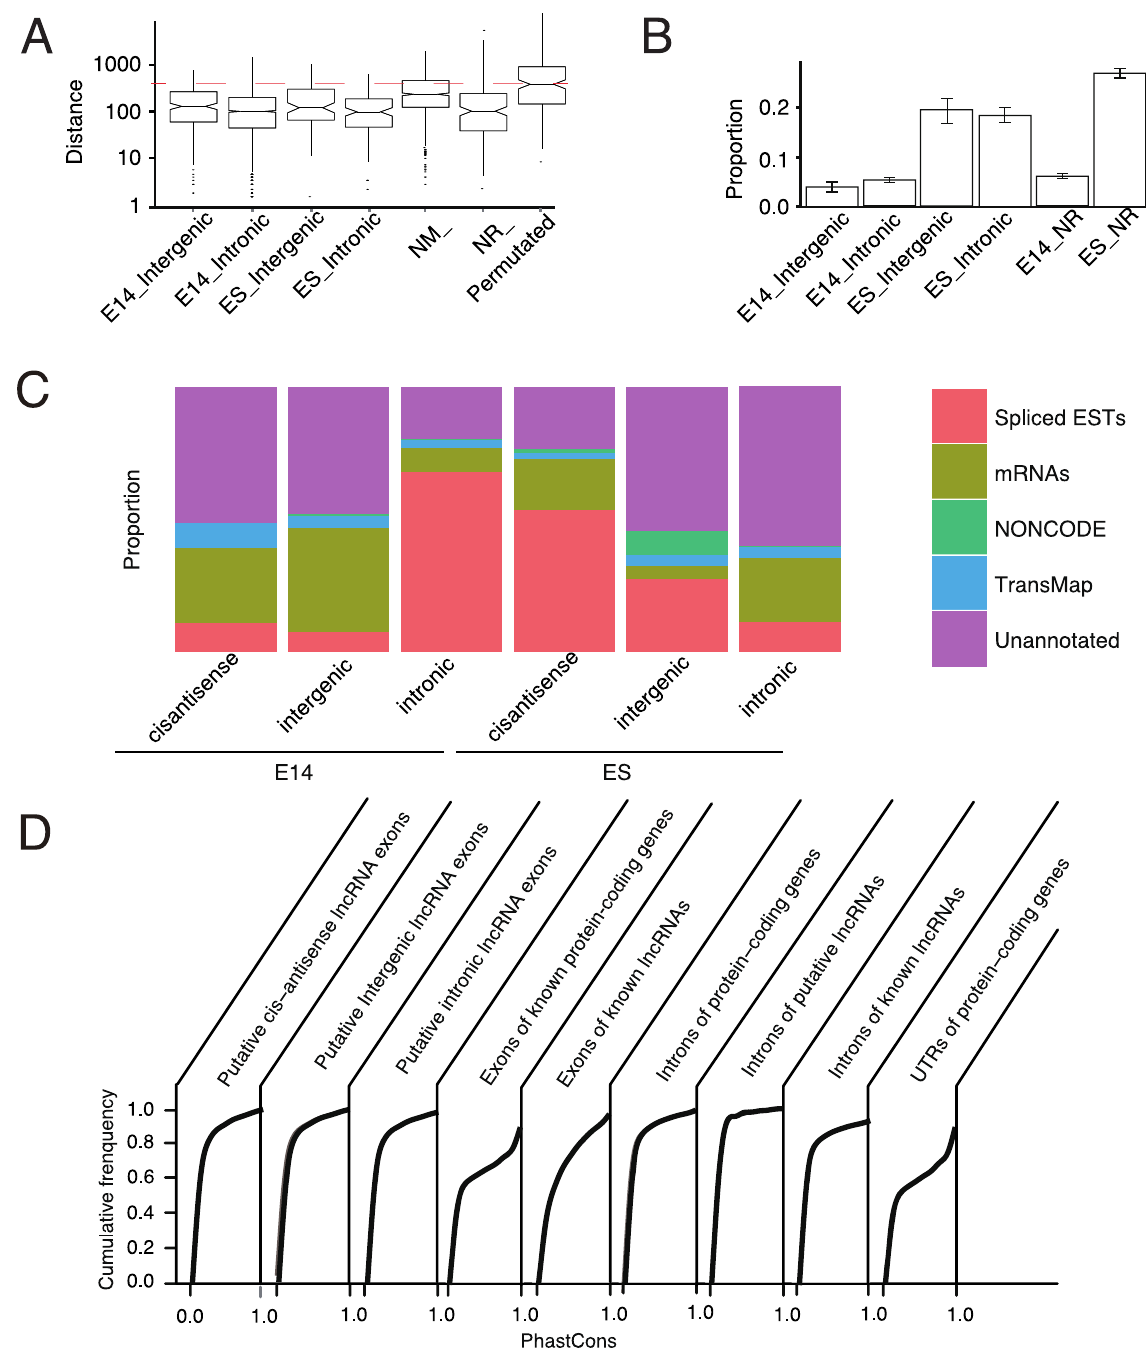
Figure 2. Genomic and transcriptional characterizations of putative embryonic brain lncRNAs. (A) Putative embryonic brain lncRNAs tend to have complete 5 9 ends based on the annotation of CAGE clusters. The shortest distances of any CAGE clusters to all putative TSSs of putative lncRNAs are calculated. We compare the distances with that of putative ES lncRNAs, known genes and permutated putative embryonic brain lncRNAs. The red dash line indicates the median distance of permutated lncRNAs. (B) Few putative embryonic brain lncRNAs are translated. We apply Ribosome footprint data [57] to investigate the proportion of translation ability for our lncRNA sets. Remarkably here, we observe significant low proportion of putative lncRNAs in ES cell and embryonic brain, while comparable with known long non-coding genes (NR_) expressed in ES cell and embryonic brain. (C) Annotation of putative lncRNAs by genomic resources. Stacked plots are shown for putative lncRNAs mapped to spliced ESTs, known mRNAs, lncRNAs from NONCODE database, and the left are classified as ‘‘Unannotated’’. To avoid redundant annotations among different genomic elements for lncRNAs, the order of annotation is forced bottom-up from ESTs to TransMap, leaving those without any annotations labeled as ‘‘Unannotated’’. For putative embryonic brain lncRNAs, the major annotation sources are ESTs and mRNAs. (D) The cumulative distribution of median PhastCons scores across 33 placental mammal subset of species for putative embryonic brain lncRNAs, compared to introns of putative embryonic brain lncRNAs, known lncRNA and protein-coding genes, exons of known long protein-coding genes and known lncRNAs and UTRs of protein-coding genes. Only a small proportion of putative embryonic brain lncRNAs are highly conserved among mammals and most of those lncRNAs show low overall conservation level. Introns of putative embryonic brain lncRNAs, however, show even less conserved fractions, compared